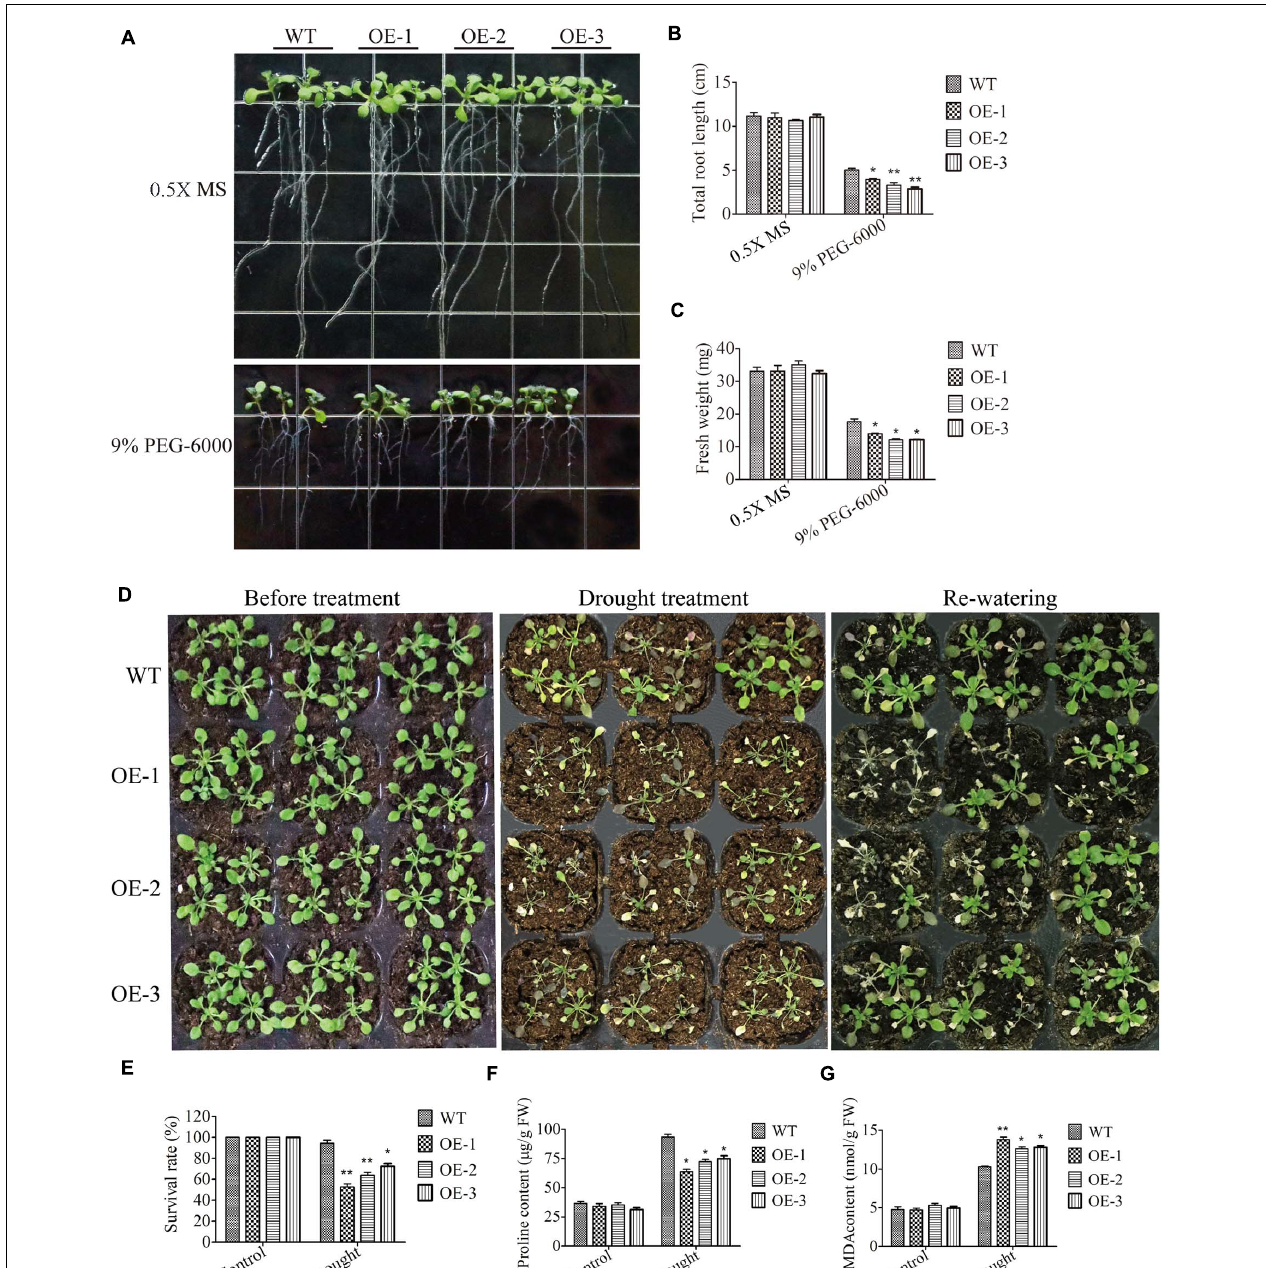
FIGURE 8 | Overexpression of SiMADS51 reduced drought tolerance in transgenic Arabidopsis plants. (A) Root length assays of wild-type (WT) and SiMADS51 -overexpressing plants under normal conditions and PEG-6000 treatment. (B) Total root lengths of seedlings. (C) Fresh weight of normal and PEG-6000 stressed plants. (D) Drought tolerance phenotypes of WT and SiMADS51 transgenic Arabidopsis in soil. Three-week-old seedlings of WT and SiMADS51 -overexpressing lines were dehydrated for 1 week and then rehydrated for 3 days. (E) Survival rate of normal and drought-stressed plants. (F) Proline and (G) MDA content were detected in WT and OE plants under drought or normal growth condition. Data are presented as the means ± SDs of three independent replicates. The asterisks indicate significant differences between WT and SiMADS51 -overexpressing lines (* P < 0.05; ** P < 0.01; Student’s t